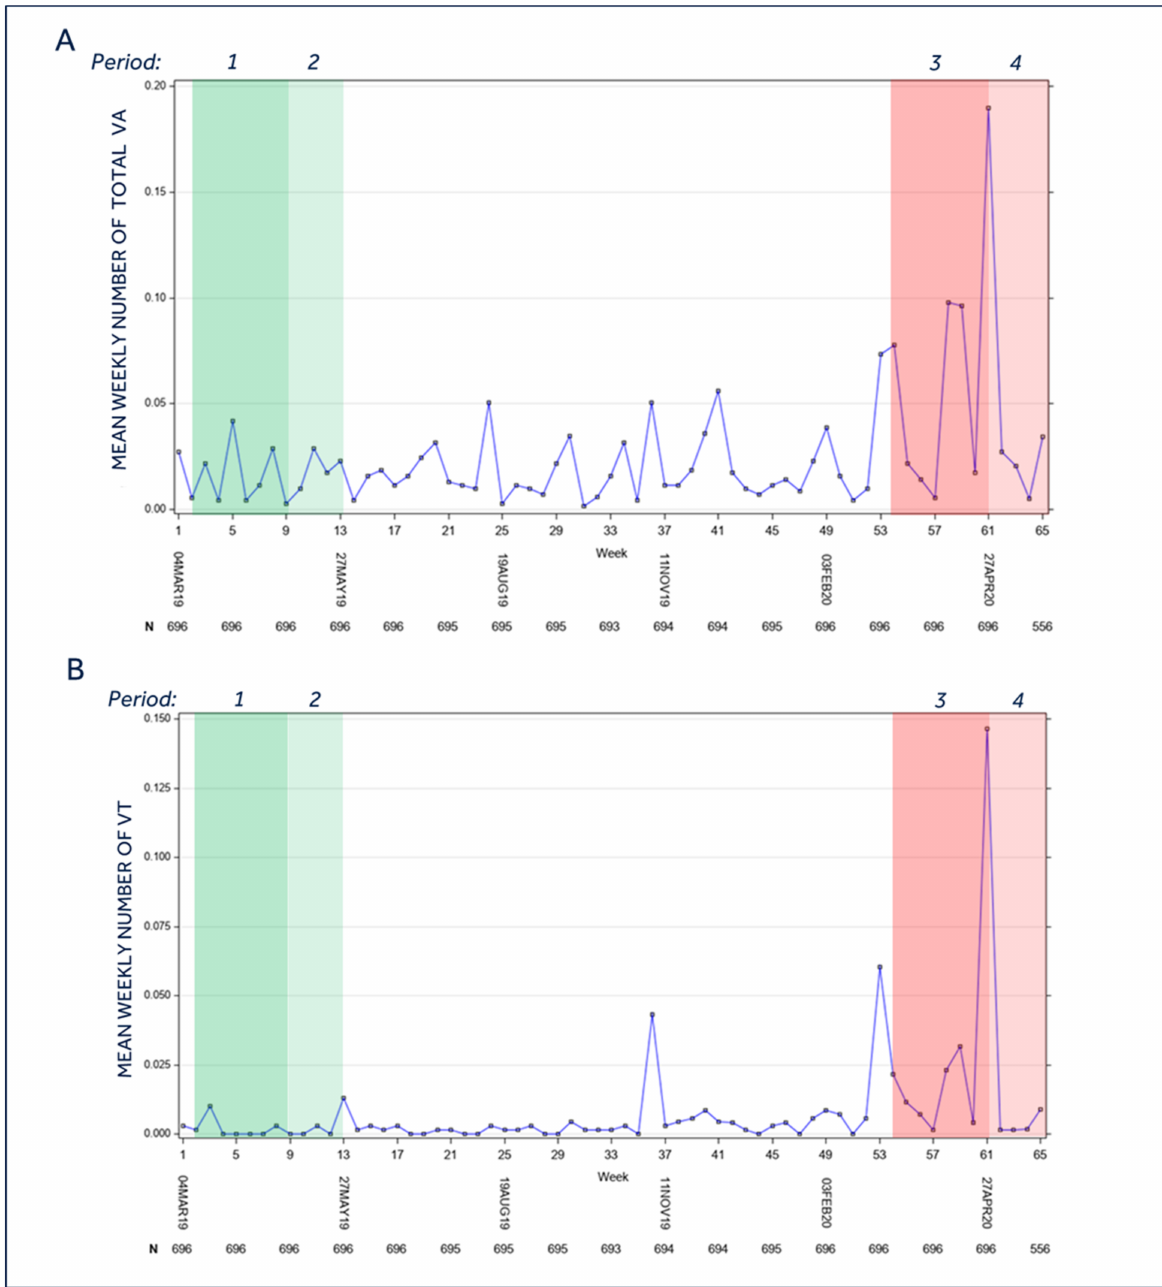
Figure 4. Burden of ventricular arrhythmias of the entire population during the study period. ( A ). Mean weekly number of ventricular arrhythmias (VT monitor, VT, FVT and VF); ( B ) Mean weekly number of ventricular tachycardias (VT). end: Period 1 = Lockdown control period (year 2019); Period 2 = Post-lockdown control period (year 2019); Period 3 = Lockdown period (year 2020); Period 4 = Post-lockdown period (year 2020). For the temporal definition of the three periods please see the Methods section; VA = ventricular arrhythmias; VT = ventricular tachycardias; ( A ): p = 0.026 for mean period 3 vs. mean period 1 ; p = 0.0338 for mean period 3 vs. mean period 4 ; p = N.S. for all other comparisons. ( B ): p = 0.024 for mean period 3 vs. mean period 1 ; p = 0.0035 for mean period 3 vs. mean period 4 ; p = N.S. for all other